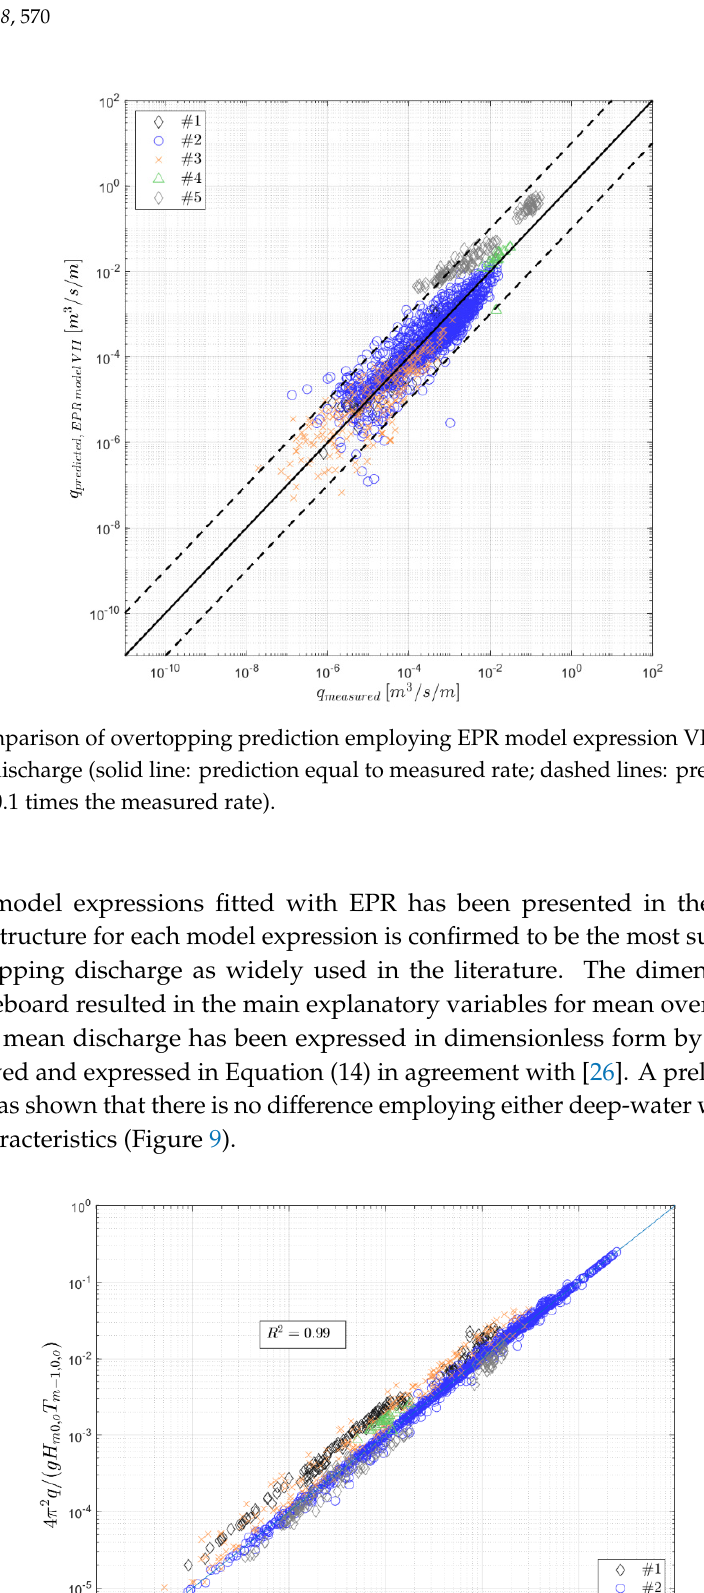
Figure 7. Comparison of overtopping prediction employing EPR model expression III and measured overtopping discharge (solid line: prediction equal to measured rate; dashed lines: prediction equal to 10 times and 0.1 times the measured rate).